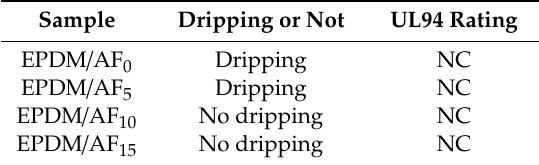
Table 6. Combustion test results of ceramifiable EPDM composites. Sample